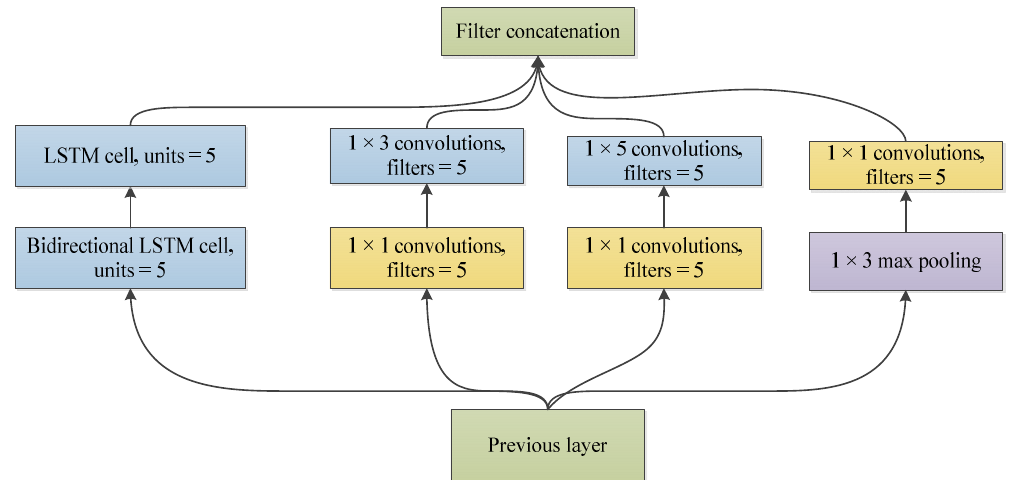
Figure 3. Inception—long short-term memory (LSTM) module used in this paper.